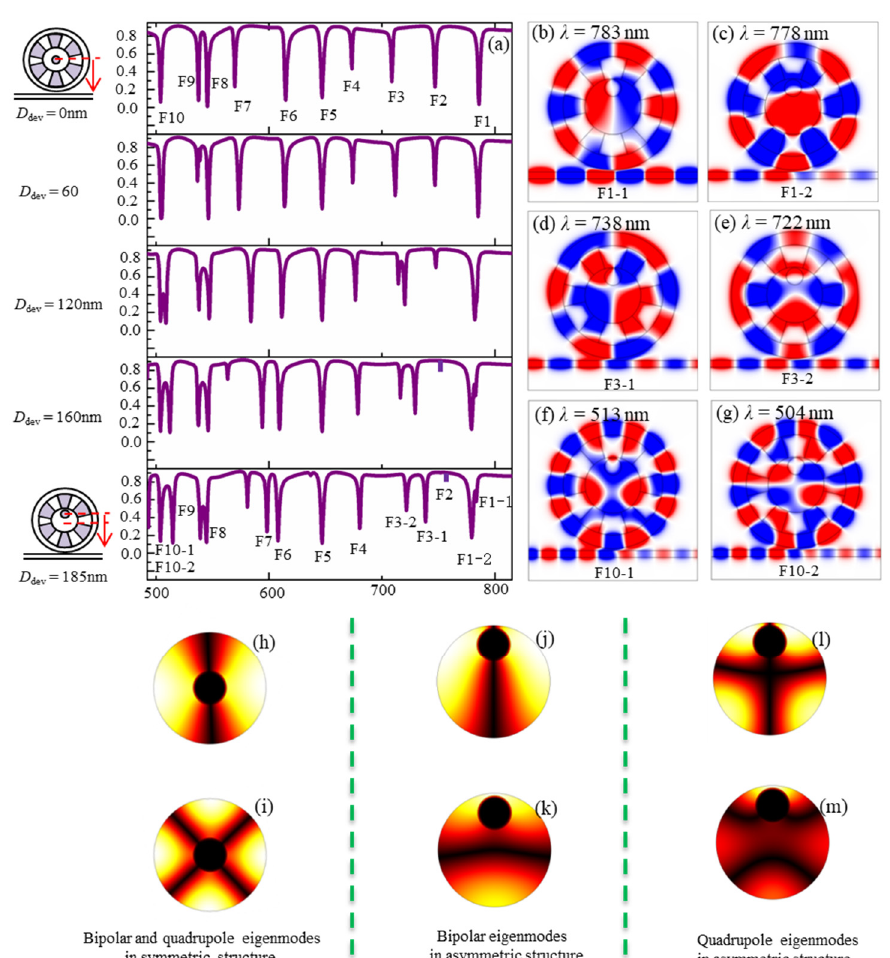
Figure 7. ( a ) The influence of the offset distance D dev of the metal core on the transmission spectra. The simulated magnetic-field H z distributions at the transmission dips of modes ( b ) F1-1 with λ = 783 nm, ( c ) F1-2 with λ = 778 nm, ( d ) F3-1 with λ = 738 nm, ( e ) F3-2 with λ = 722 nm, ( f ) F10-1 with λ = 513 nm, and ( g ) F10-2 with λ = 504 nm. The | H | distributions of the metal-core cavity for ( h ) bipole and ( i ) quadrupole eigenmodes in the symmetric structure with D dev = 0, and in the asymmetric structure with D dev = 185 nm, ( j , k ) bipole eigenmodes, and ( l , m ) quadrupole eigenmodes.